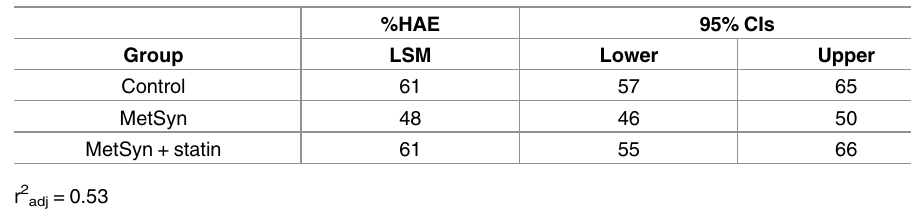
Table 3. Group differences in HAE a .